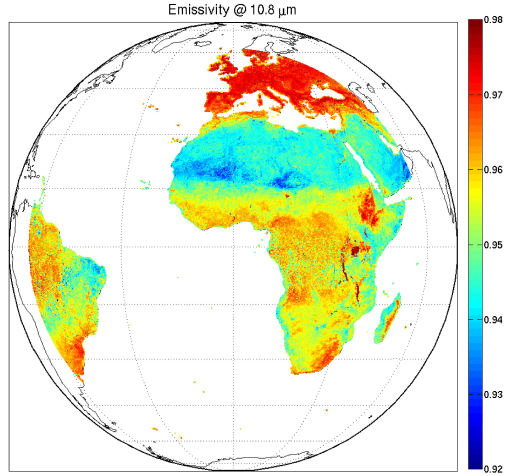
Figure 21. November 2007 map of channel emissivity at 12µm over the SEVIRI full